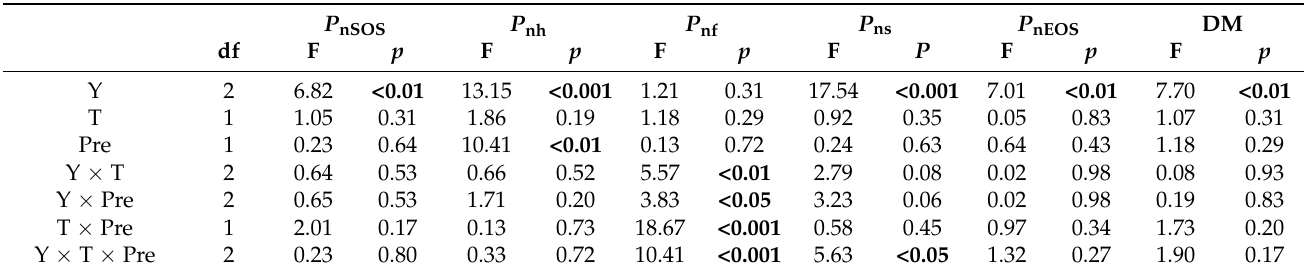
Table 2. Main and interactive effects of the year (Y), temperature (T), and precipitation (Pre) on the net CO 2 assimilation rate ( P n ) and dry mass of Stipa krylovii .